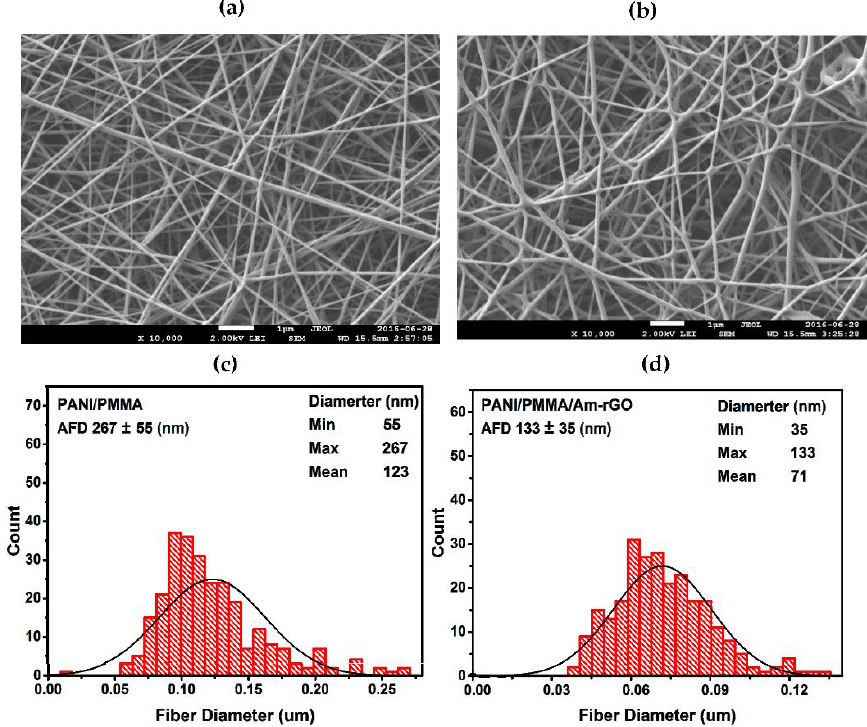
Figure 6. ( a , c ) SEM micrograph of the PANI/PMMA and PANI/PMMA/Am-rGO nanofibers, respectively; ( b , d ) the distribution of dimeters of the PANI/PMMA and PANI/PMMA/Am-rGO nanofibers, respectively.